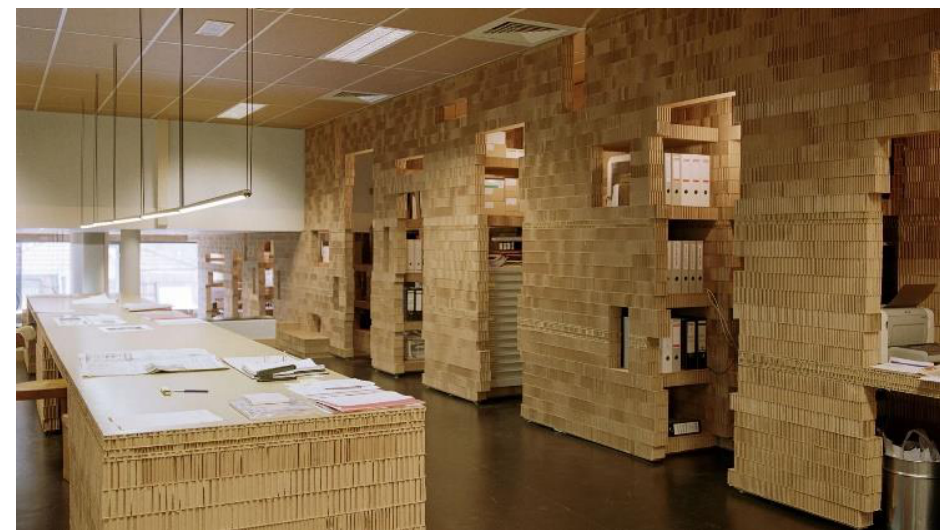
Figure 6. Use of cardboard as panel (Interior of Scherpontwerp, Eindhoven [65]).